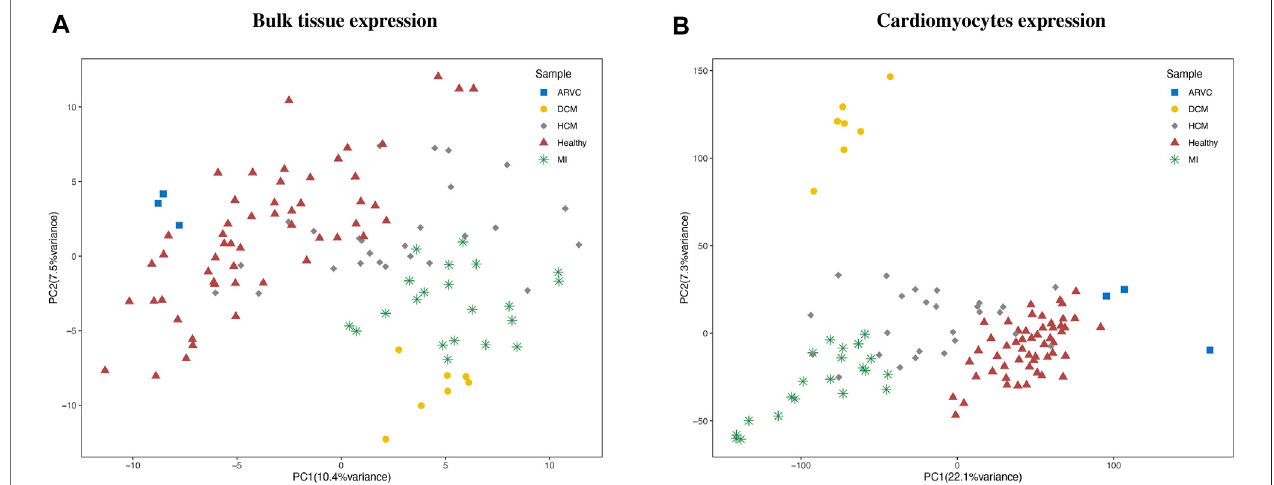
FIGURE 2 | Clustering of bulk RNA-seq expression pro fi les and reconstructed cardiomyocyte expression pro fi les. The principal component analysis clustering results using (A) bulk expression pro fi le and (B) reconstructed cardiomyocyte expression pro fi les arelabeled according to the disease condition of each sample. ARVC, arrhythmogenic right ventricular cardiomyopathy; DCM, dilated cardiomyopathy; HCM, hypertrophic cardiomyopathy; MI, myocardial infarction.